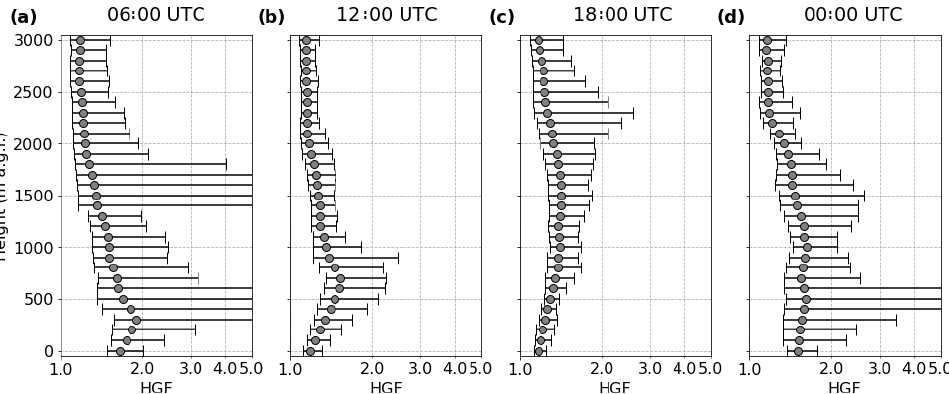
Figure 5. The mean and standard deviation of estimated hygroscopic growth factors at (a) 06:00UTC, (b) 12:00UTC, (c) 18:00UTC and (d) 00:00UTC. Where the upper value cannot be seen is where the air became saturated.